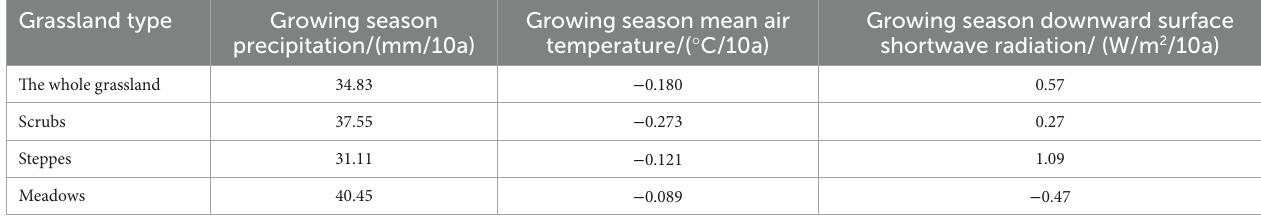
TABLE 2 Change trend of growing season meteorological factors for grassland vegetation on Mongolian Plateau from 2000 to 2018. Grassland